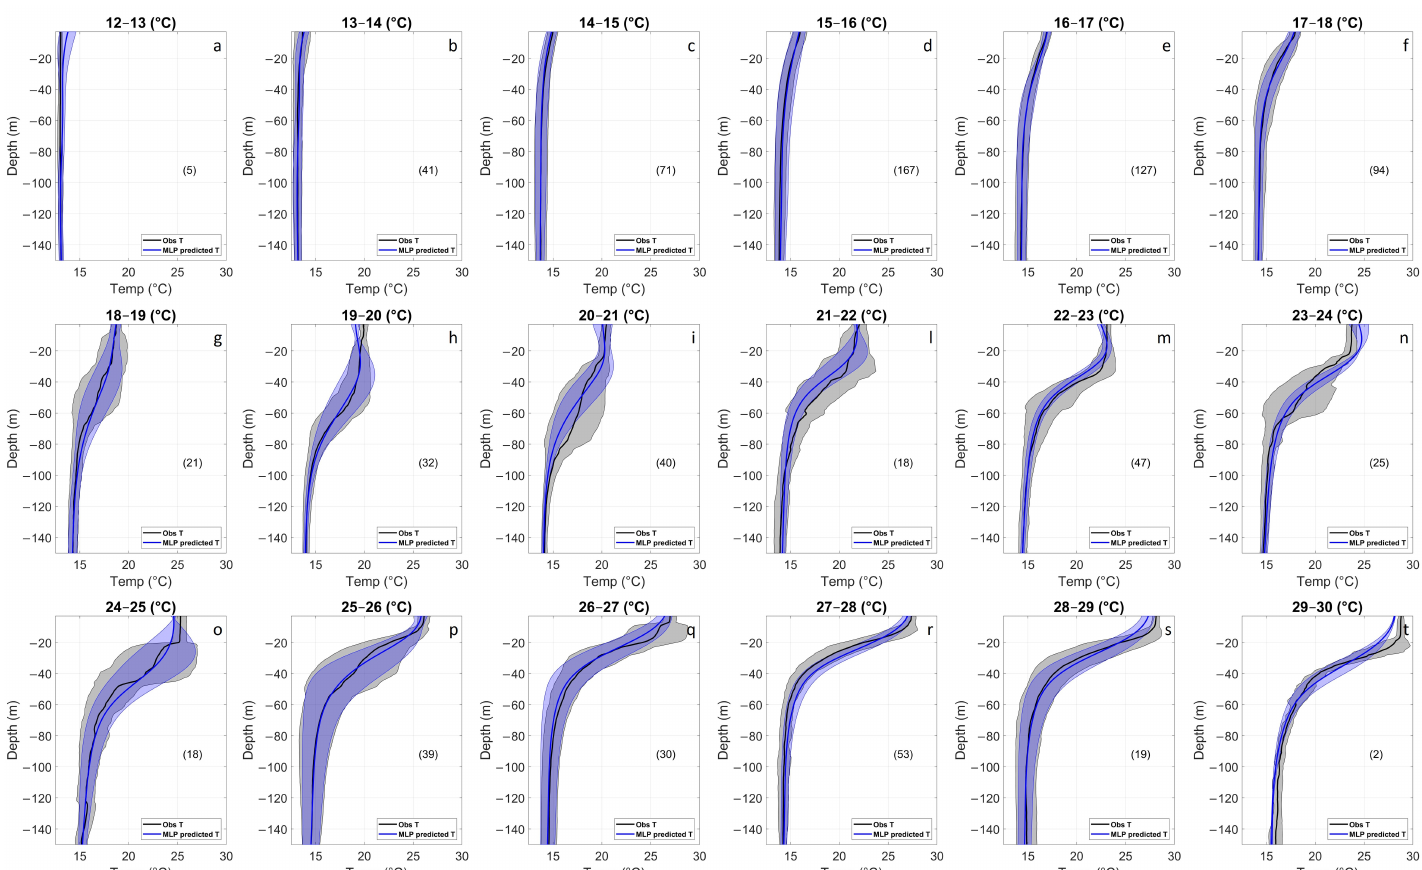
Figure 8. ( a – i , l – t ) Comparison of the mean profiles of the observed (black line) and MLP (blue line) temperature values modelled from surface satellite data and grouped according to di ff erent surface temperature classes (in bold at the top of each panel). For each panel the black line is computed averaging all the observed profiles falling within specific surface temperature class. The blue line is obtained from the average of all MLP corresponding profiles. The shaded areas represent their respective standard deviations. The number in brackets refers to frequency of training observed profiles for each surface trophic class. These results are referred to the test